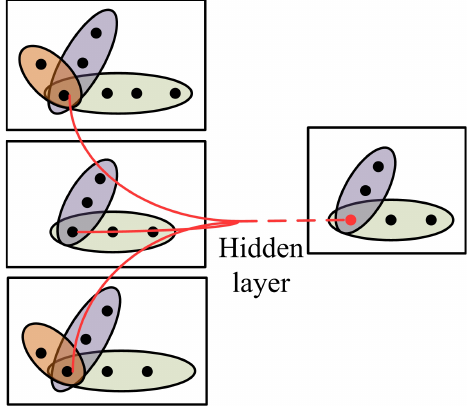
Figure 2. The embedding process of the evolving hypergraph convolution. (Node features in different time periods are aggregated and updated through the hidden